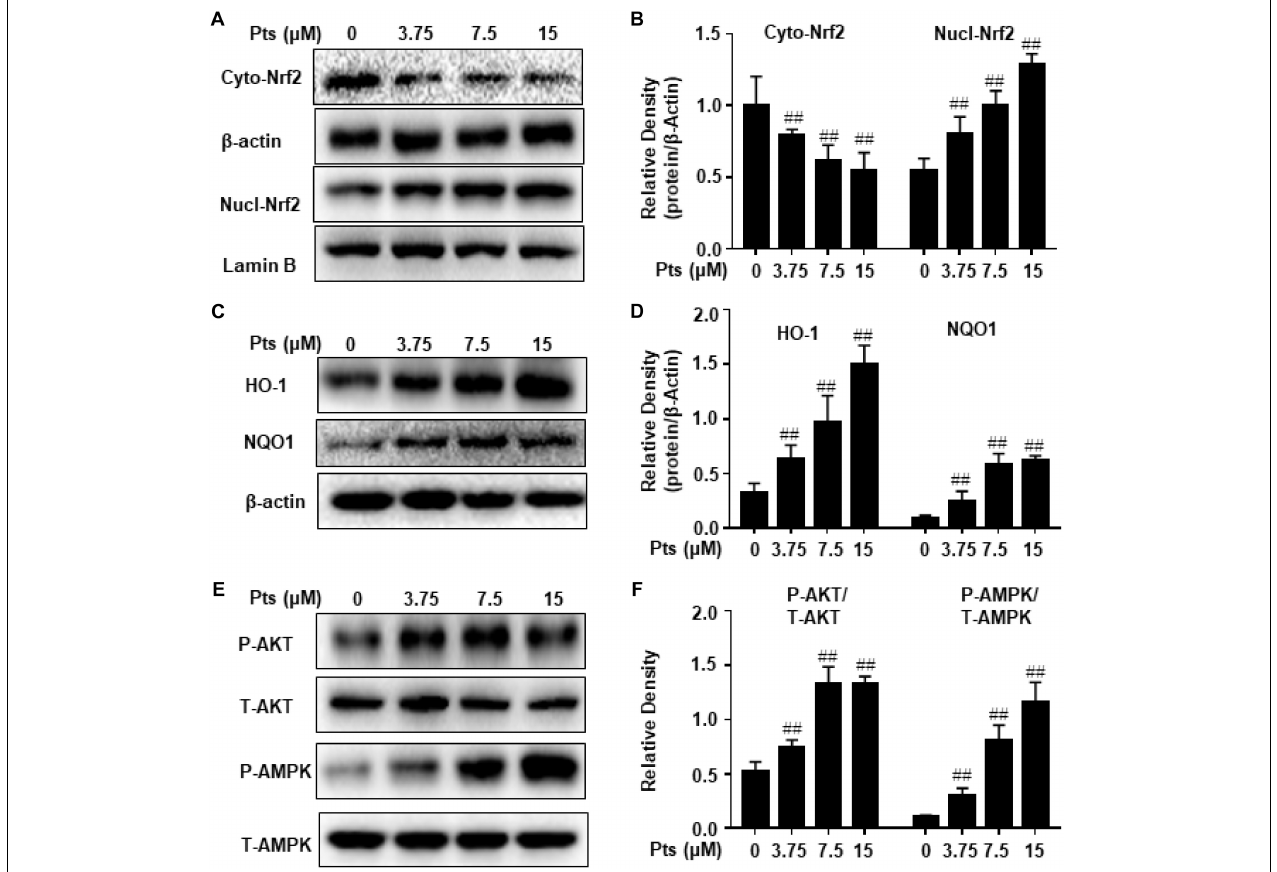
FIGURE 6 | Effect of Pts on AMPK and AKT phosphorylation, Nrf2 translocation and antioxidant enzyme expression. HaCaT cells were plated in six-well culture plates and treated with Pts (3.75, 7.5, and 15 µ M) for 24 h. Nuclear and cytoplasmic extracts from cells were prepared for detecting Nrf2 in panels (A,B) and total protein extracts from cells were prepared for detecting HO-1, NQO1, AMPK and AKT in panels (C–F) . The results are expressed as the means ± S.E.M. of three independent experiments. ## P ≤ 0.01 versus the control